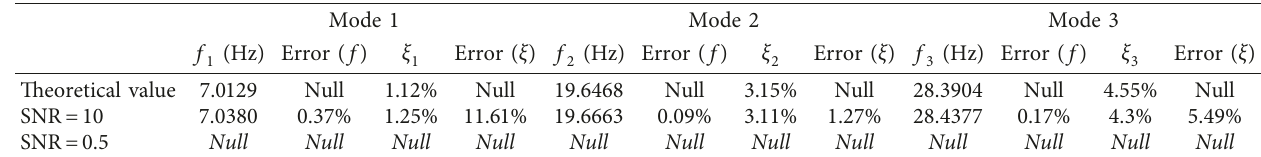
Table 2: Cov-SSI results.